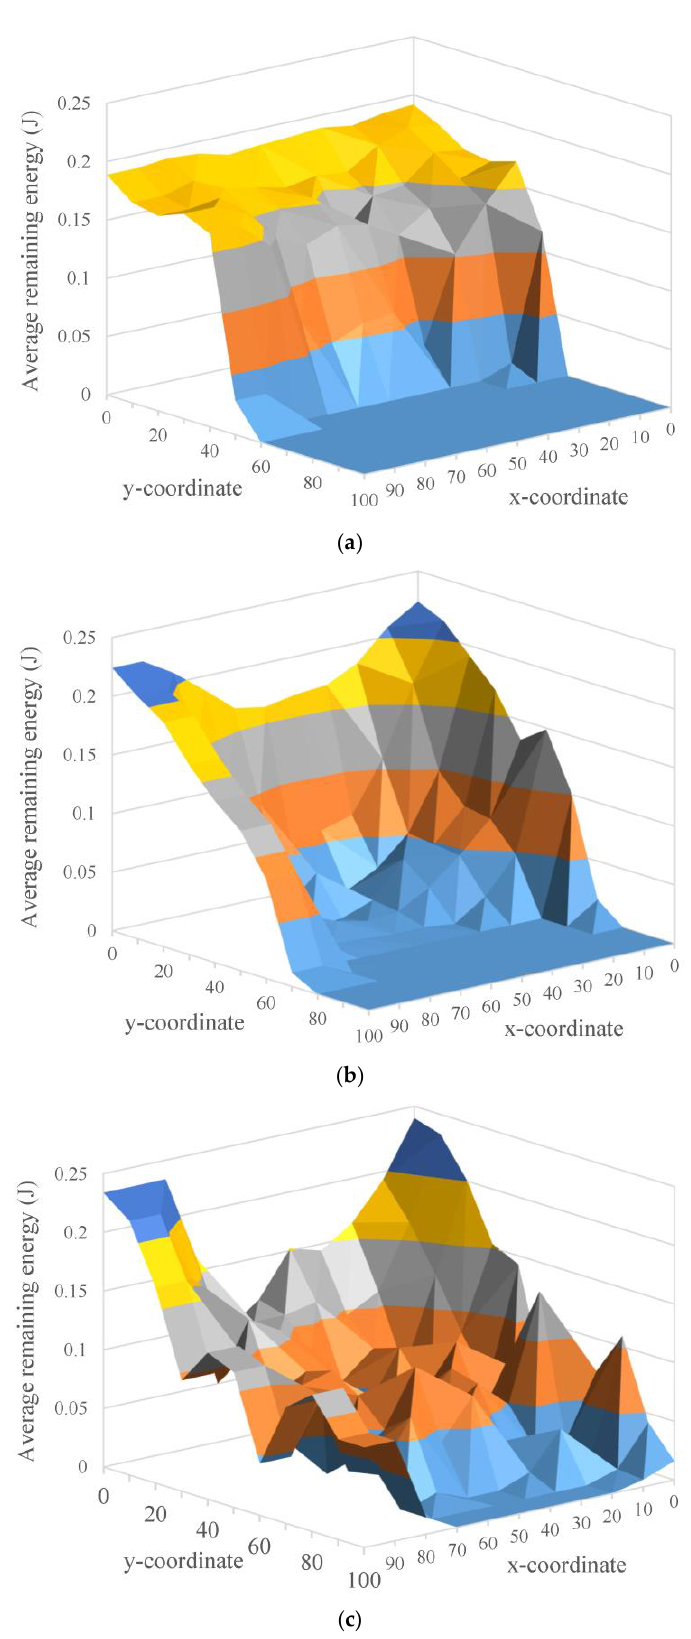
Figure 9. Energy distribution for sensing nodes: ( a ) LB-TBDAS; ( b ) GB-PEDAP; ( c ) PEDAP.